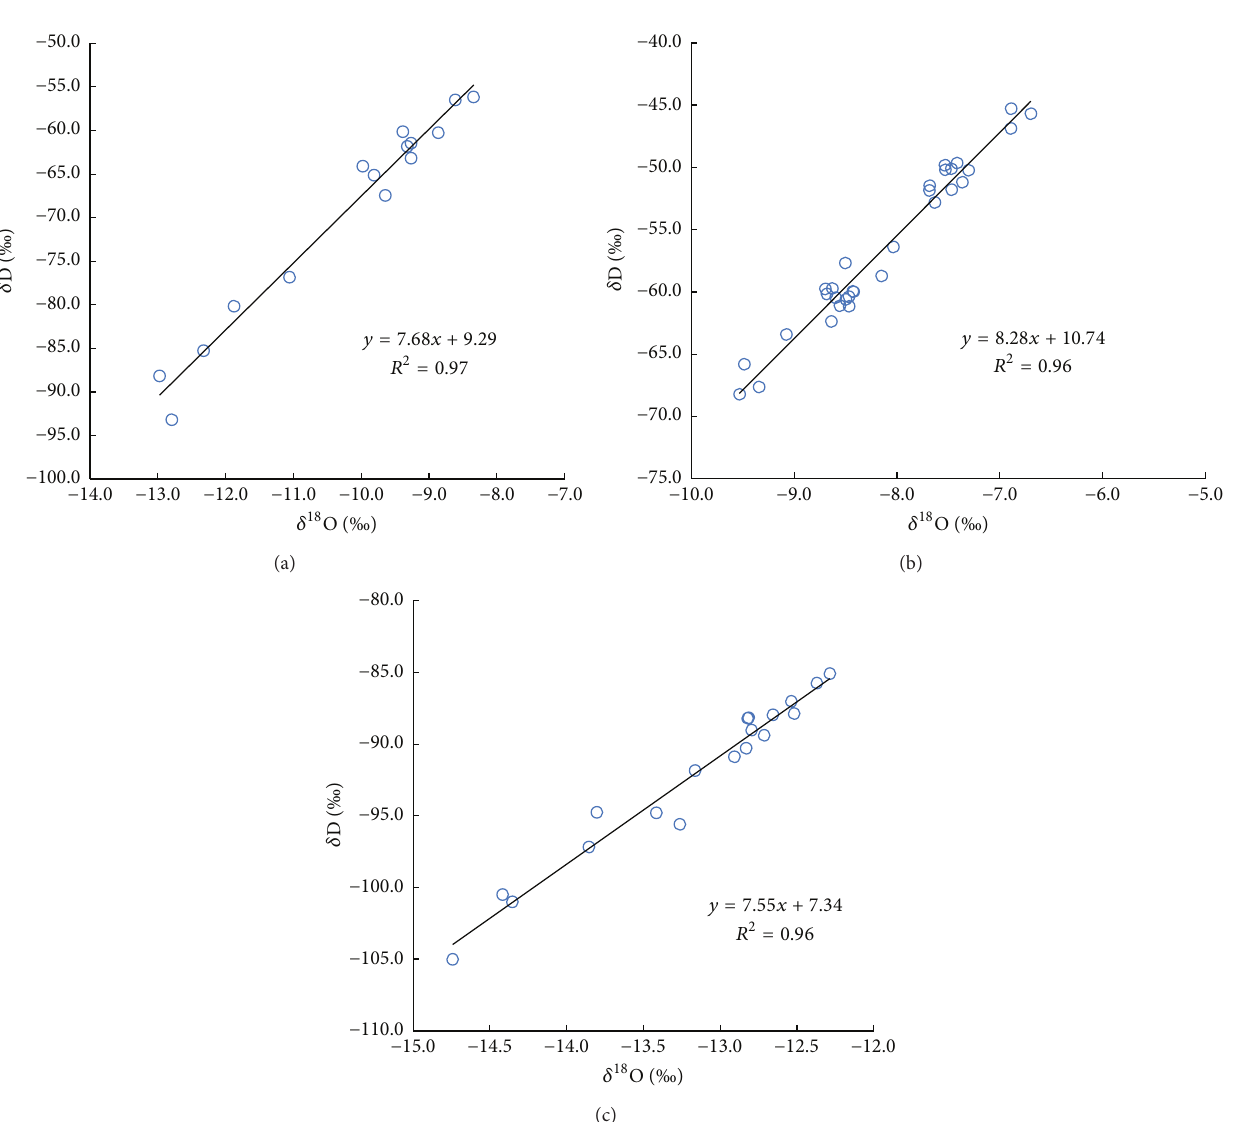
the concentration of Cl − decreased because of the weakening of dilution